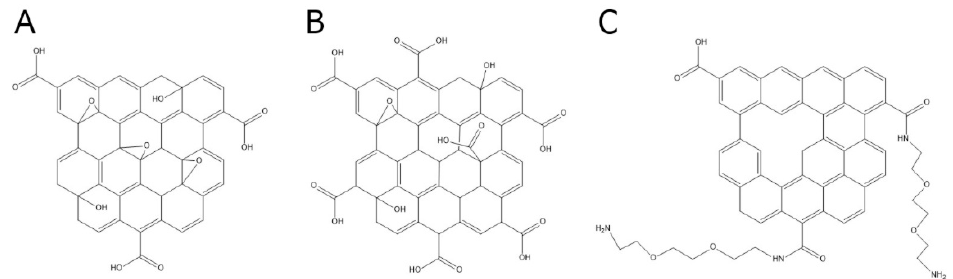
Figure 2. Chemical structure of graphenic species used in the assay. ( A ) Graphene oxide (GO), ( B ) carboxyl graphene oxide (GO-COOH), ( C ) reduced graphene oxide amino-PEG (polythiophene- g -poly) covalently linked (rGO-PEG-NH 2 ).